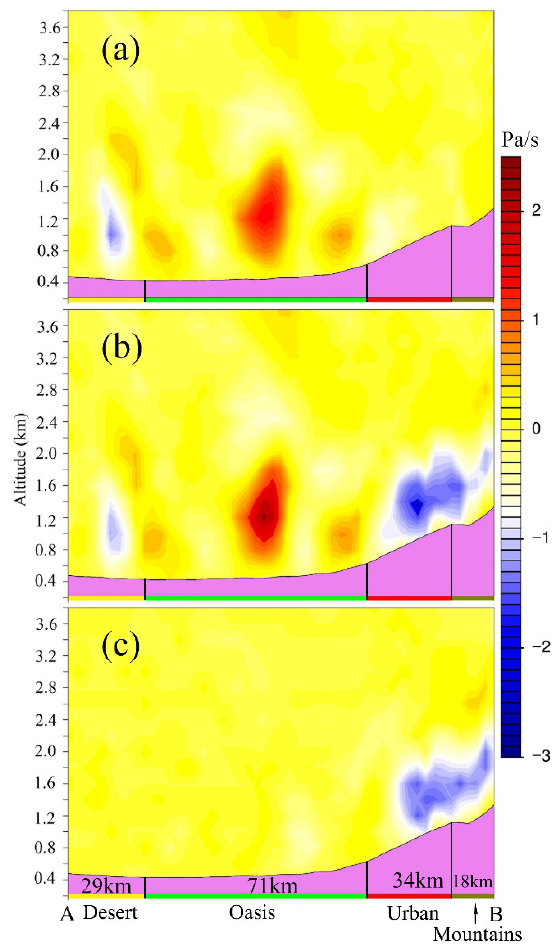
Figure 8. The vertical cross sections of vertical velocity (Pa s − 1 ) along AB (the green line in Figure 7a) at 20:00 BJT on the 11 June 2016 computed from: ( a ) NoURB—Def_NoURB, ( b ) CTL—Def_NoURB and ( c ) CTL—NoURB. The violet shaded areas at the bottom of each panel represent the terrain; along the x axis (from A to B) the yellow bar represents the extent of the desert; the green bar represents the extent of the oasis; the red bar represents the extent of the urban area; the olive bar represents the extent of mountain areas and the number represents the width of the land use type.